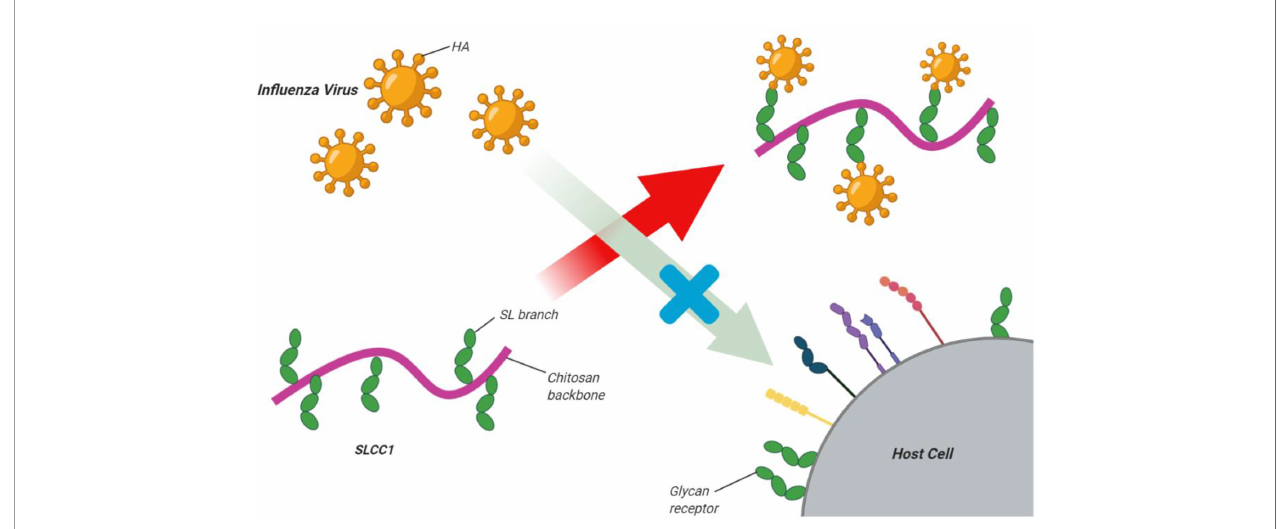
FIGURE 3 | Sialyl lactose-CH (SLCC1) derivative for inhibition of in fl uenza virus. Li et al. synthesized a sialyl lactose-CH derivative via graftinga lactoside aldehyde- functionalized aglycone onto the CH amino groups followed by enzymatic sialylation using sialyl-transferase. The glycosylated CH bound the in fl uenza virus surface hemagglutinin protein with high af fi nityto suppress virus binding to host cells. This fi gure adapted from (Li et al.,